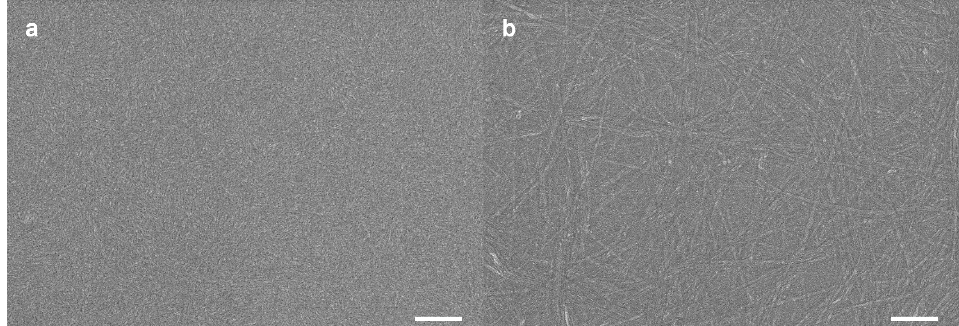
Figure 1. FE–SEM images of the aggregates of TSADA formed in benzene solution (1 mg/mL). Samples were prepared by spin coating of the benzene solution of TSADA ( a ) without heating and ( b ) after heating and subsequent cooling. Scale bar, 500 nm.